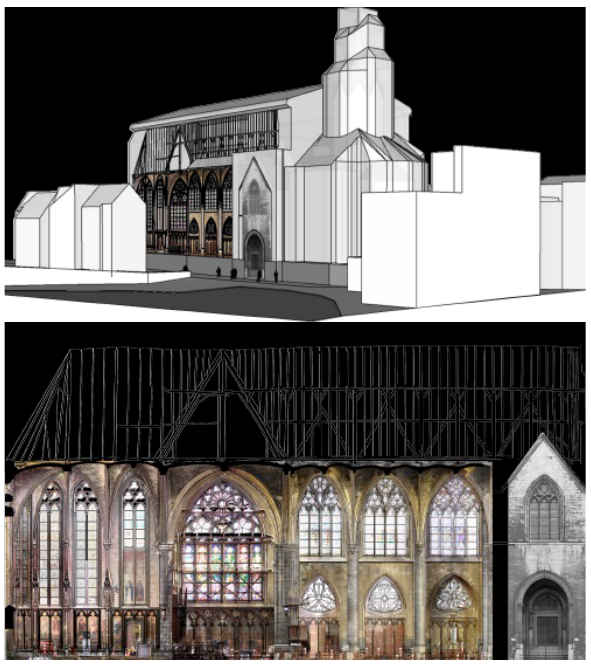
Figure 12 . A subset of the point cloud of the collegiate Sainte Croix